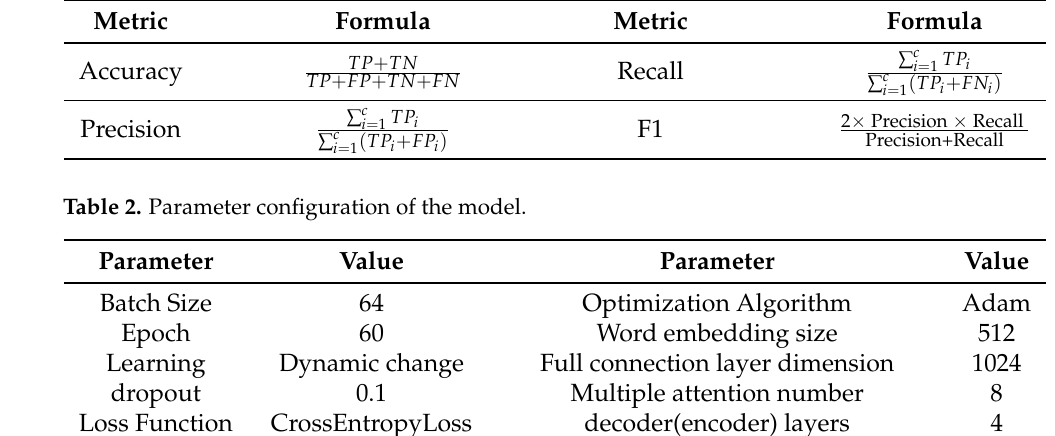
Table 1. Performance Metrics.